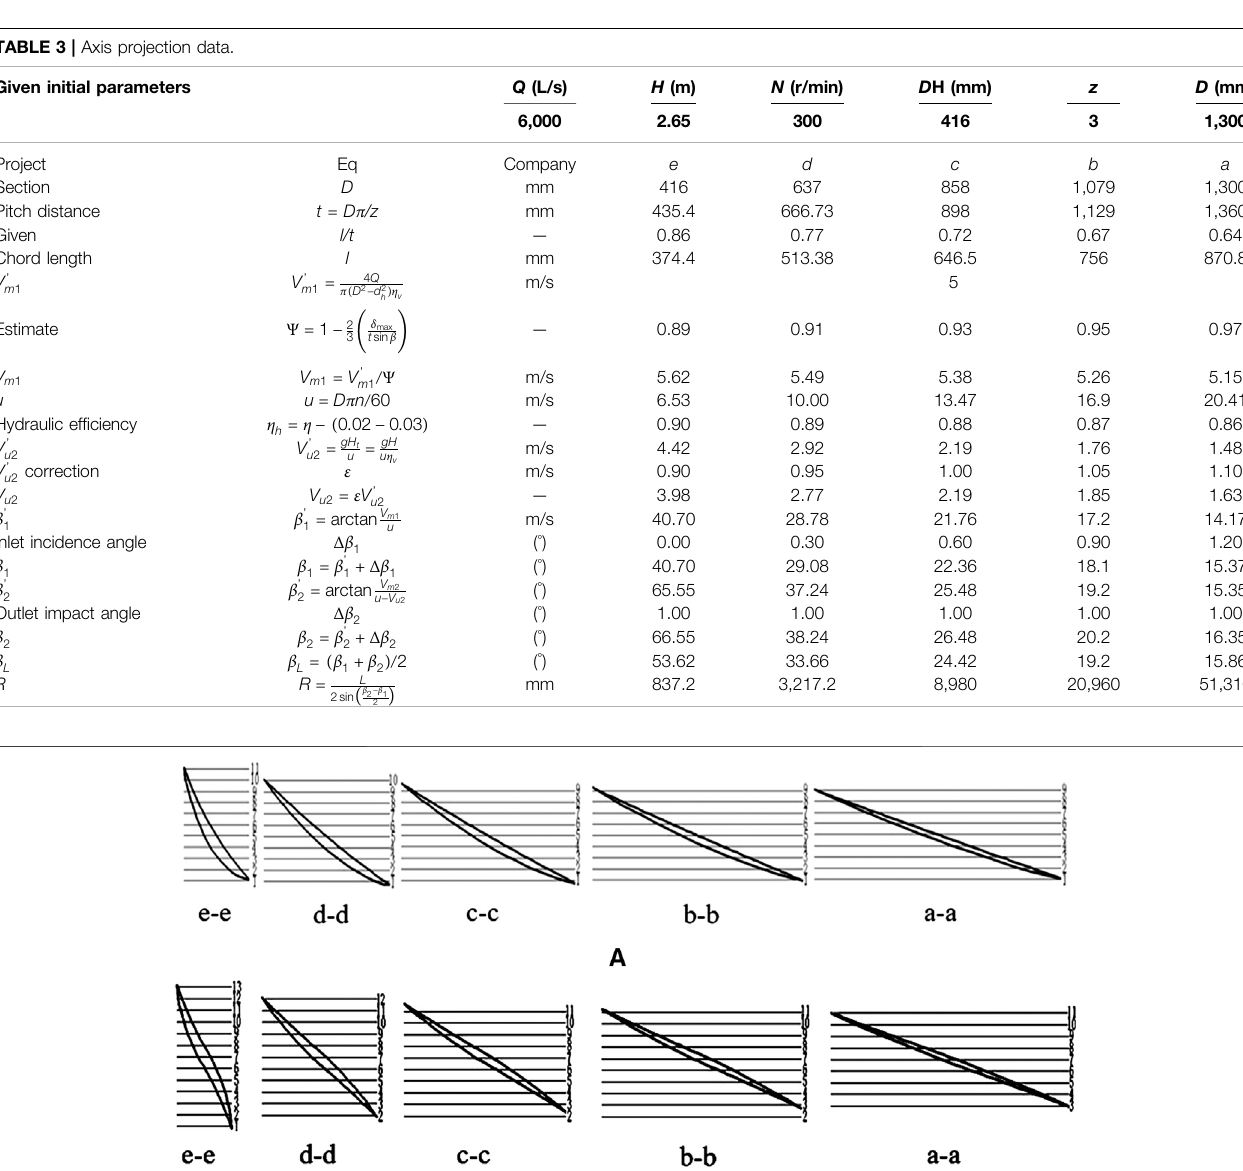
TABLE 3 | Axis projection data. Given initial parameters